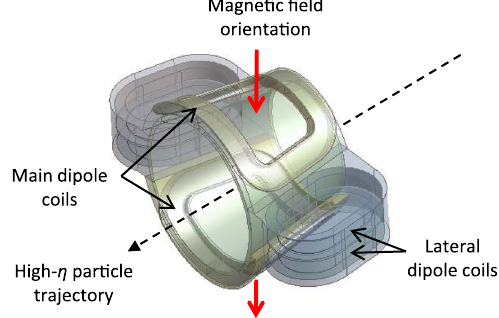
FIG. 2. Three-dimensional representation of the cold mass of the force-and-torque-neutral dipole. The main dipole coils con- tribute most of the useful field integral for particle tracking and the lateral coils return the flux generated by the main coil, thus reducing the stray field and canceling the net force and torque on the cold mass. See [2] for more details.